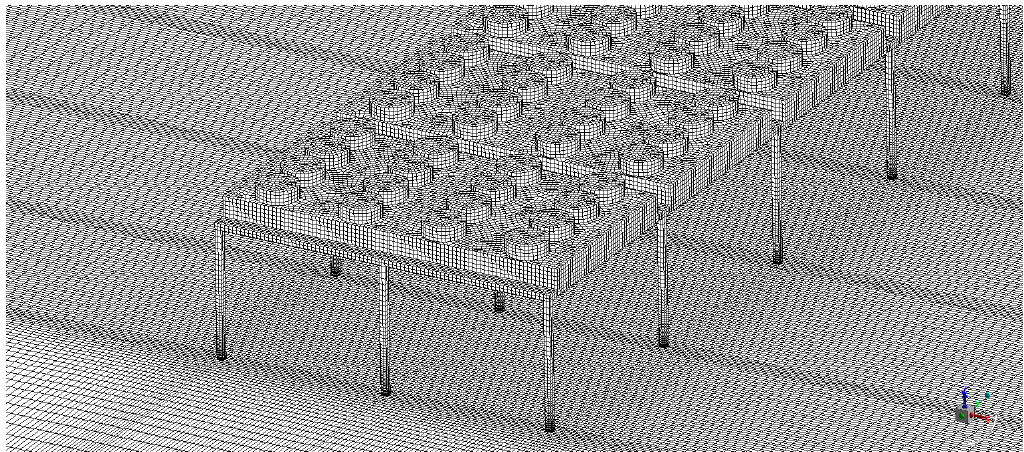
Figure 6. Mesh of the 20 evaporators (first 12 rows), at the wall surfaces.